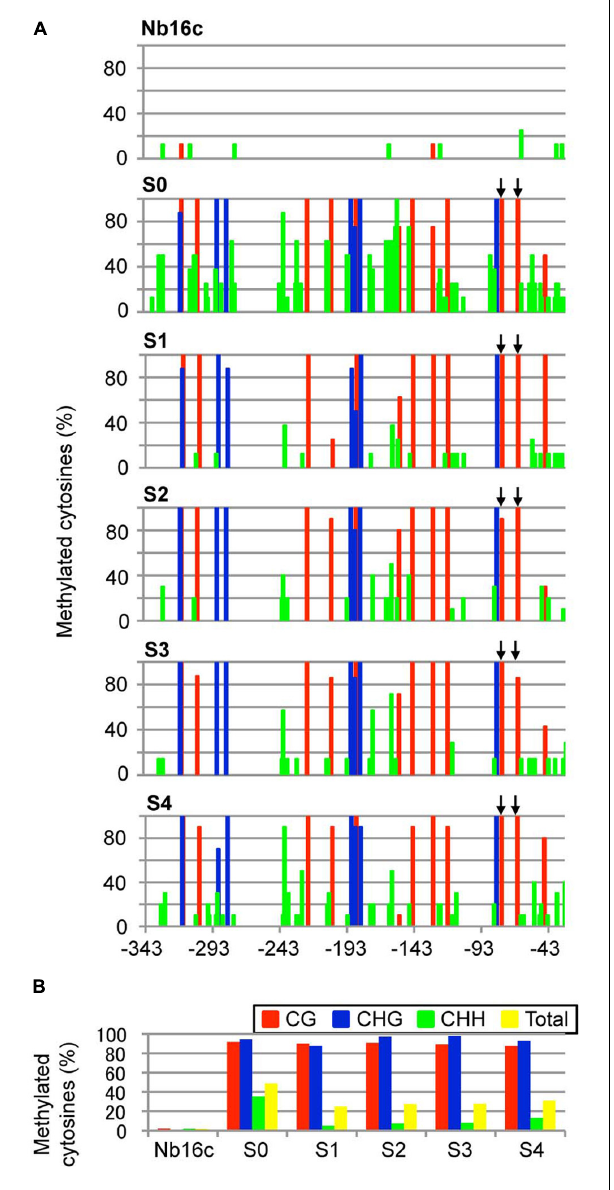
FIGURE 3 | Cytosine methylation status of the CaMV 35S promoter region. (A) Total plant DNA from mock-agroinoculated N. benthamiana line 16c plants (Nb16c), Nb16c plants infected with ALSV:35S (S0), and progeny from four generations of ALSV:35S-infected Nb16c plants (S1, S2, S3, and S4) were treated with bisulfite.The arrows indicate elements within the domain of activation sequences. (B) Summary of bisulfite sequencing analysis.The red, blue, green, and yellow bars respectively represent the percentage of cytosines methylated at the CG, CHG, CHH, and all contexts.